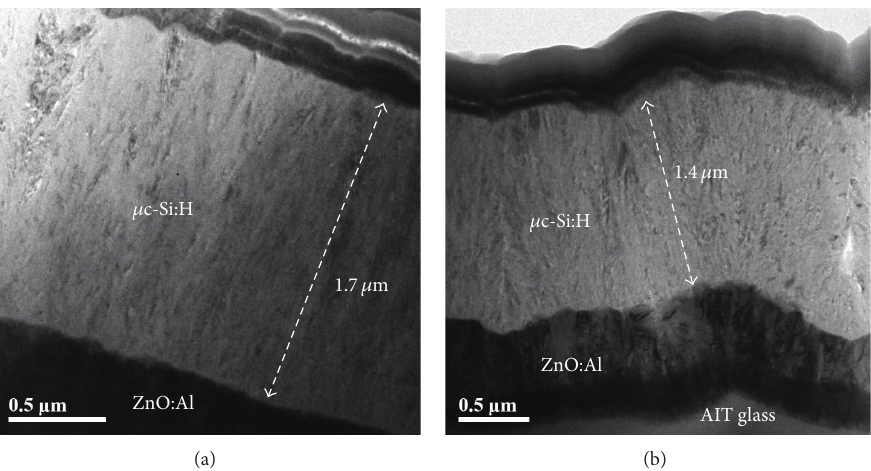
Figure 6: XTEM images of 𝜇 c-Si:H thin-film solar cells on (a) reference superstrate and (b) AIT glass superstrate.